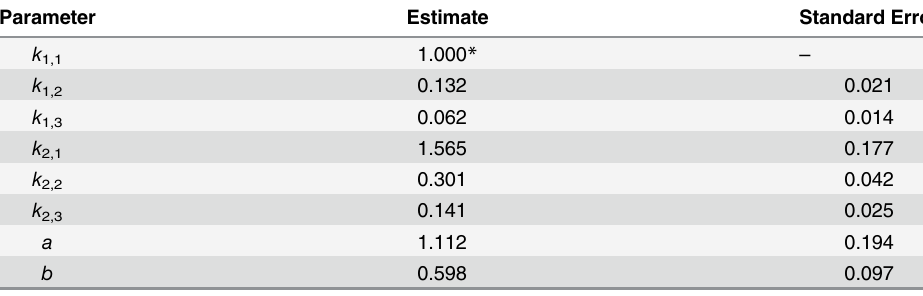
Table 6. Results of Fitting Models to Data in Table